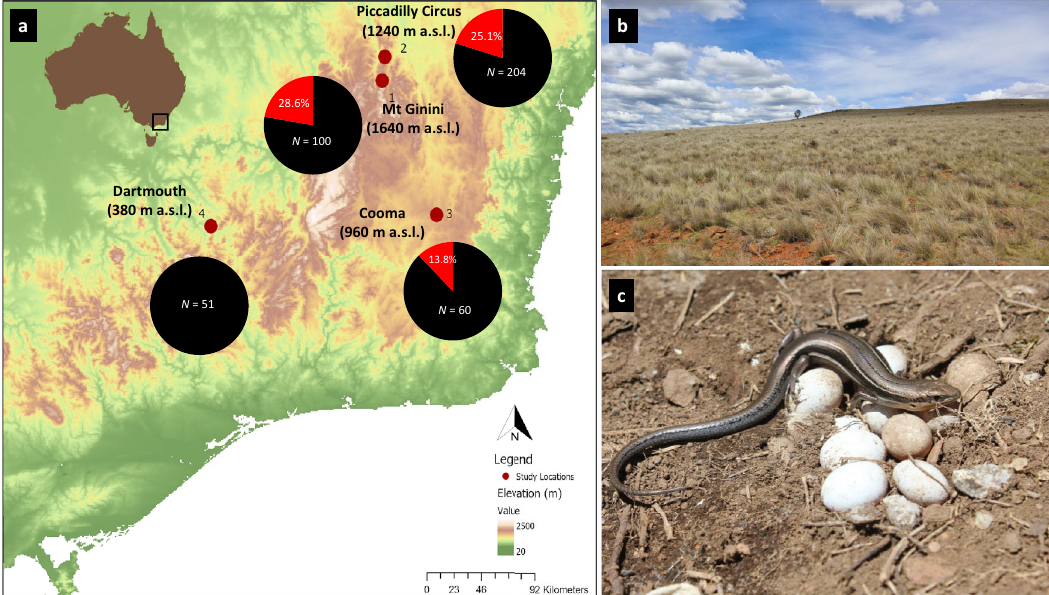
Figure 1. ( a ). Study locations and relative proportion of phenotypic males (black) and sex- reversed XX males (red). N = total number of eggs collected during the study period. Underlying map generated using ArcGIS 10.5.1 (http:// www. esri. com) and data from the Digital Elevation Model (Geoscience Australia) made available under Creative Commons Attribution 3.0 Australia (https:// creat iveco mmons. org/ licen ses/ by/3. 0/ au/ legal code, last accessed 21-Dec-20). ( b ). Typical habitat of B. duperreyi distribution (Cooma field location). ( c ). A typical nest of B. duperreyi (Location: Piccadilly Circus). All photos were taken by the first